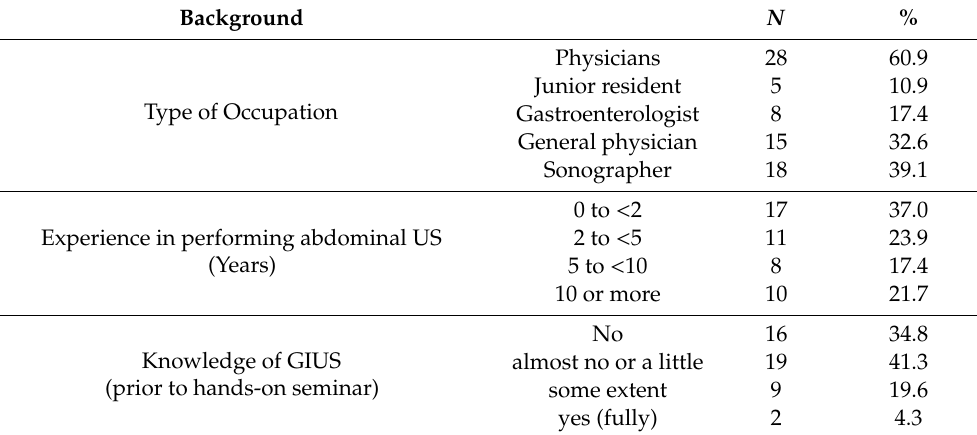
Table 2. Characteristics of the hands-on seminar participants ( n = 46).